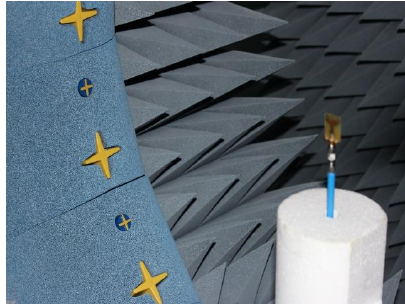
Figure 9. Antenna radiation characteristics measurement setup.